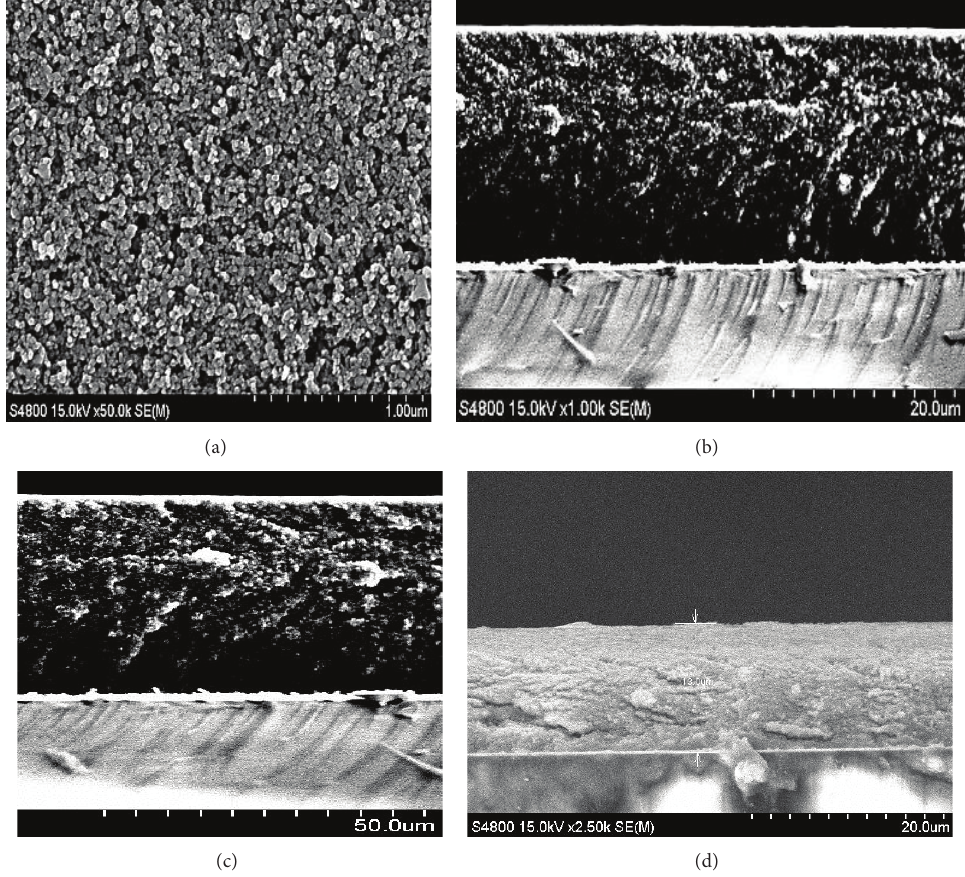
F 2: SEM images of the TiO nanoparticle �lm on FTO glass (a) vertical view� side view for spinning speed at (b) 800rpm, (c) 500rpm, and (d) 100rpm. 2